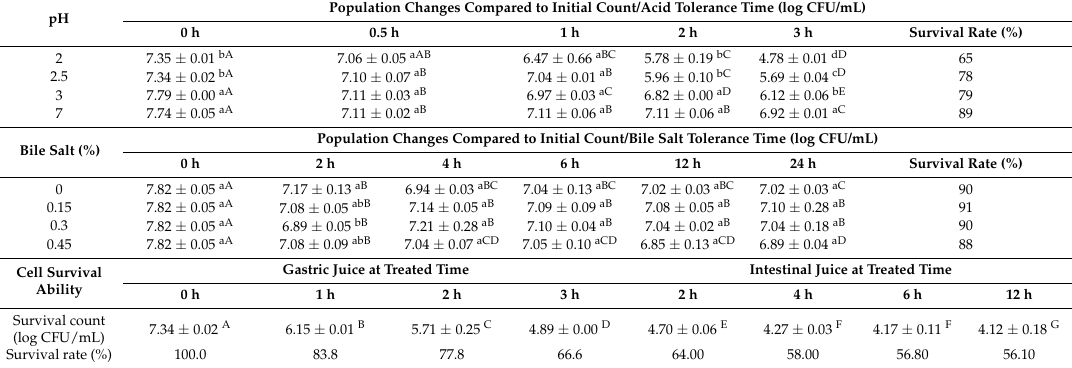
Table 2. Survival of L. brevis RK03 exposed to acid for 3 h, bile salts for 24 h, simulated gastrointestinal (GI) juice for 3 h, and intestinal juice for 12 h. PopulationChangesComparedtoInitialCount/AcidToleranceTime(logCFU/mL)